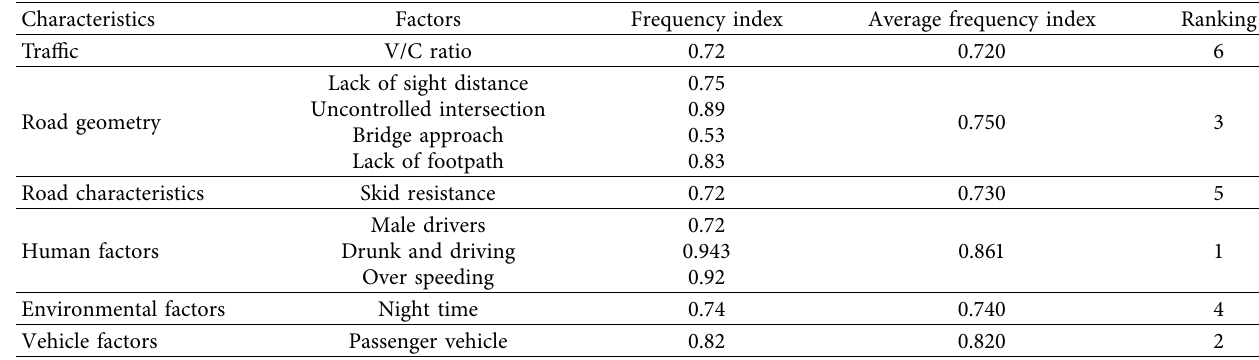
Table 5: Leading